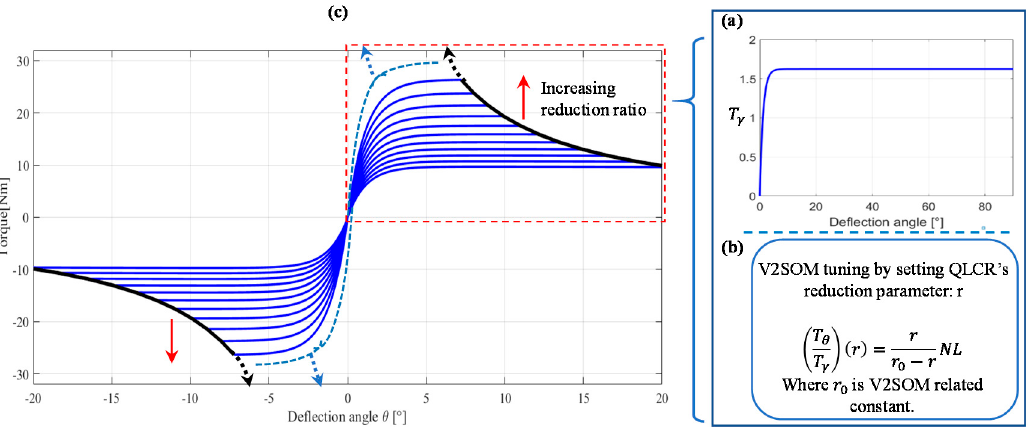
Figure 7. ( a ) Example of V2SOM basic torque curve with ( b ) quasi-linear continuous reducer (QLCR); ( c ) illustration of the V2SOM torque characteristic with seven QLCR settings.